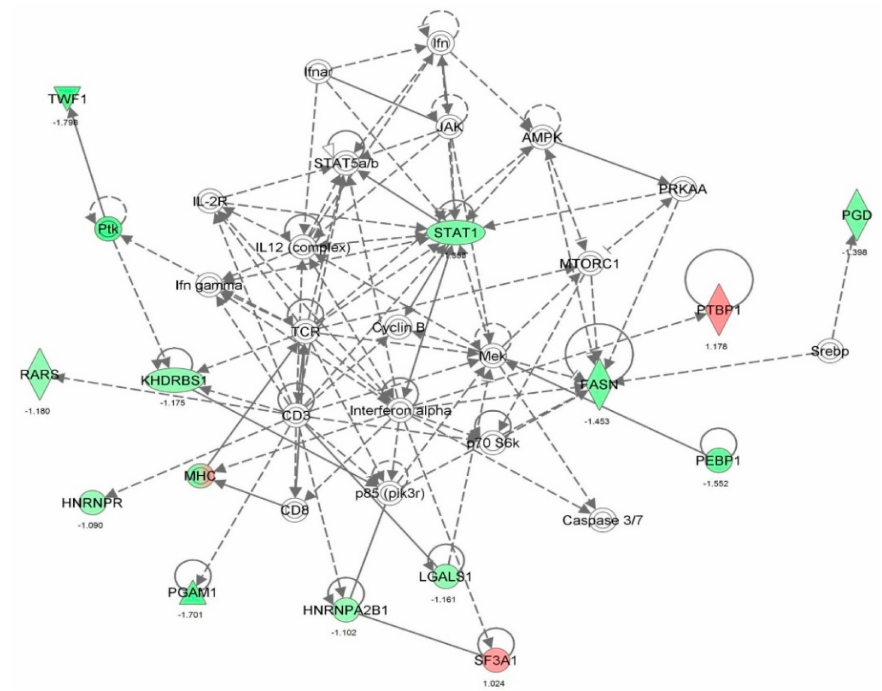
Figure 23. Vancomycin regulated RNA post-transcriptional modification, dermatological diseases and conditions, cell death and survival. Red indicates an up-regulation; green indicates a down-regulation. The intensity of green and redcolors indicates the degree of down- or up-regulation. Solid arrow indicates direct interaction and dashed arrow indicates indirect